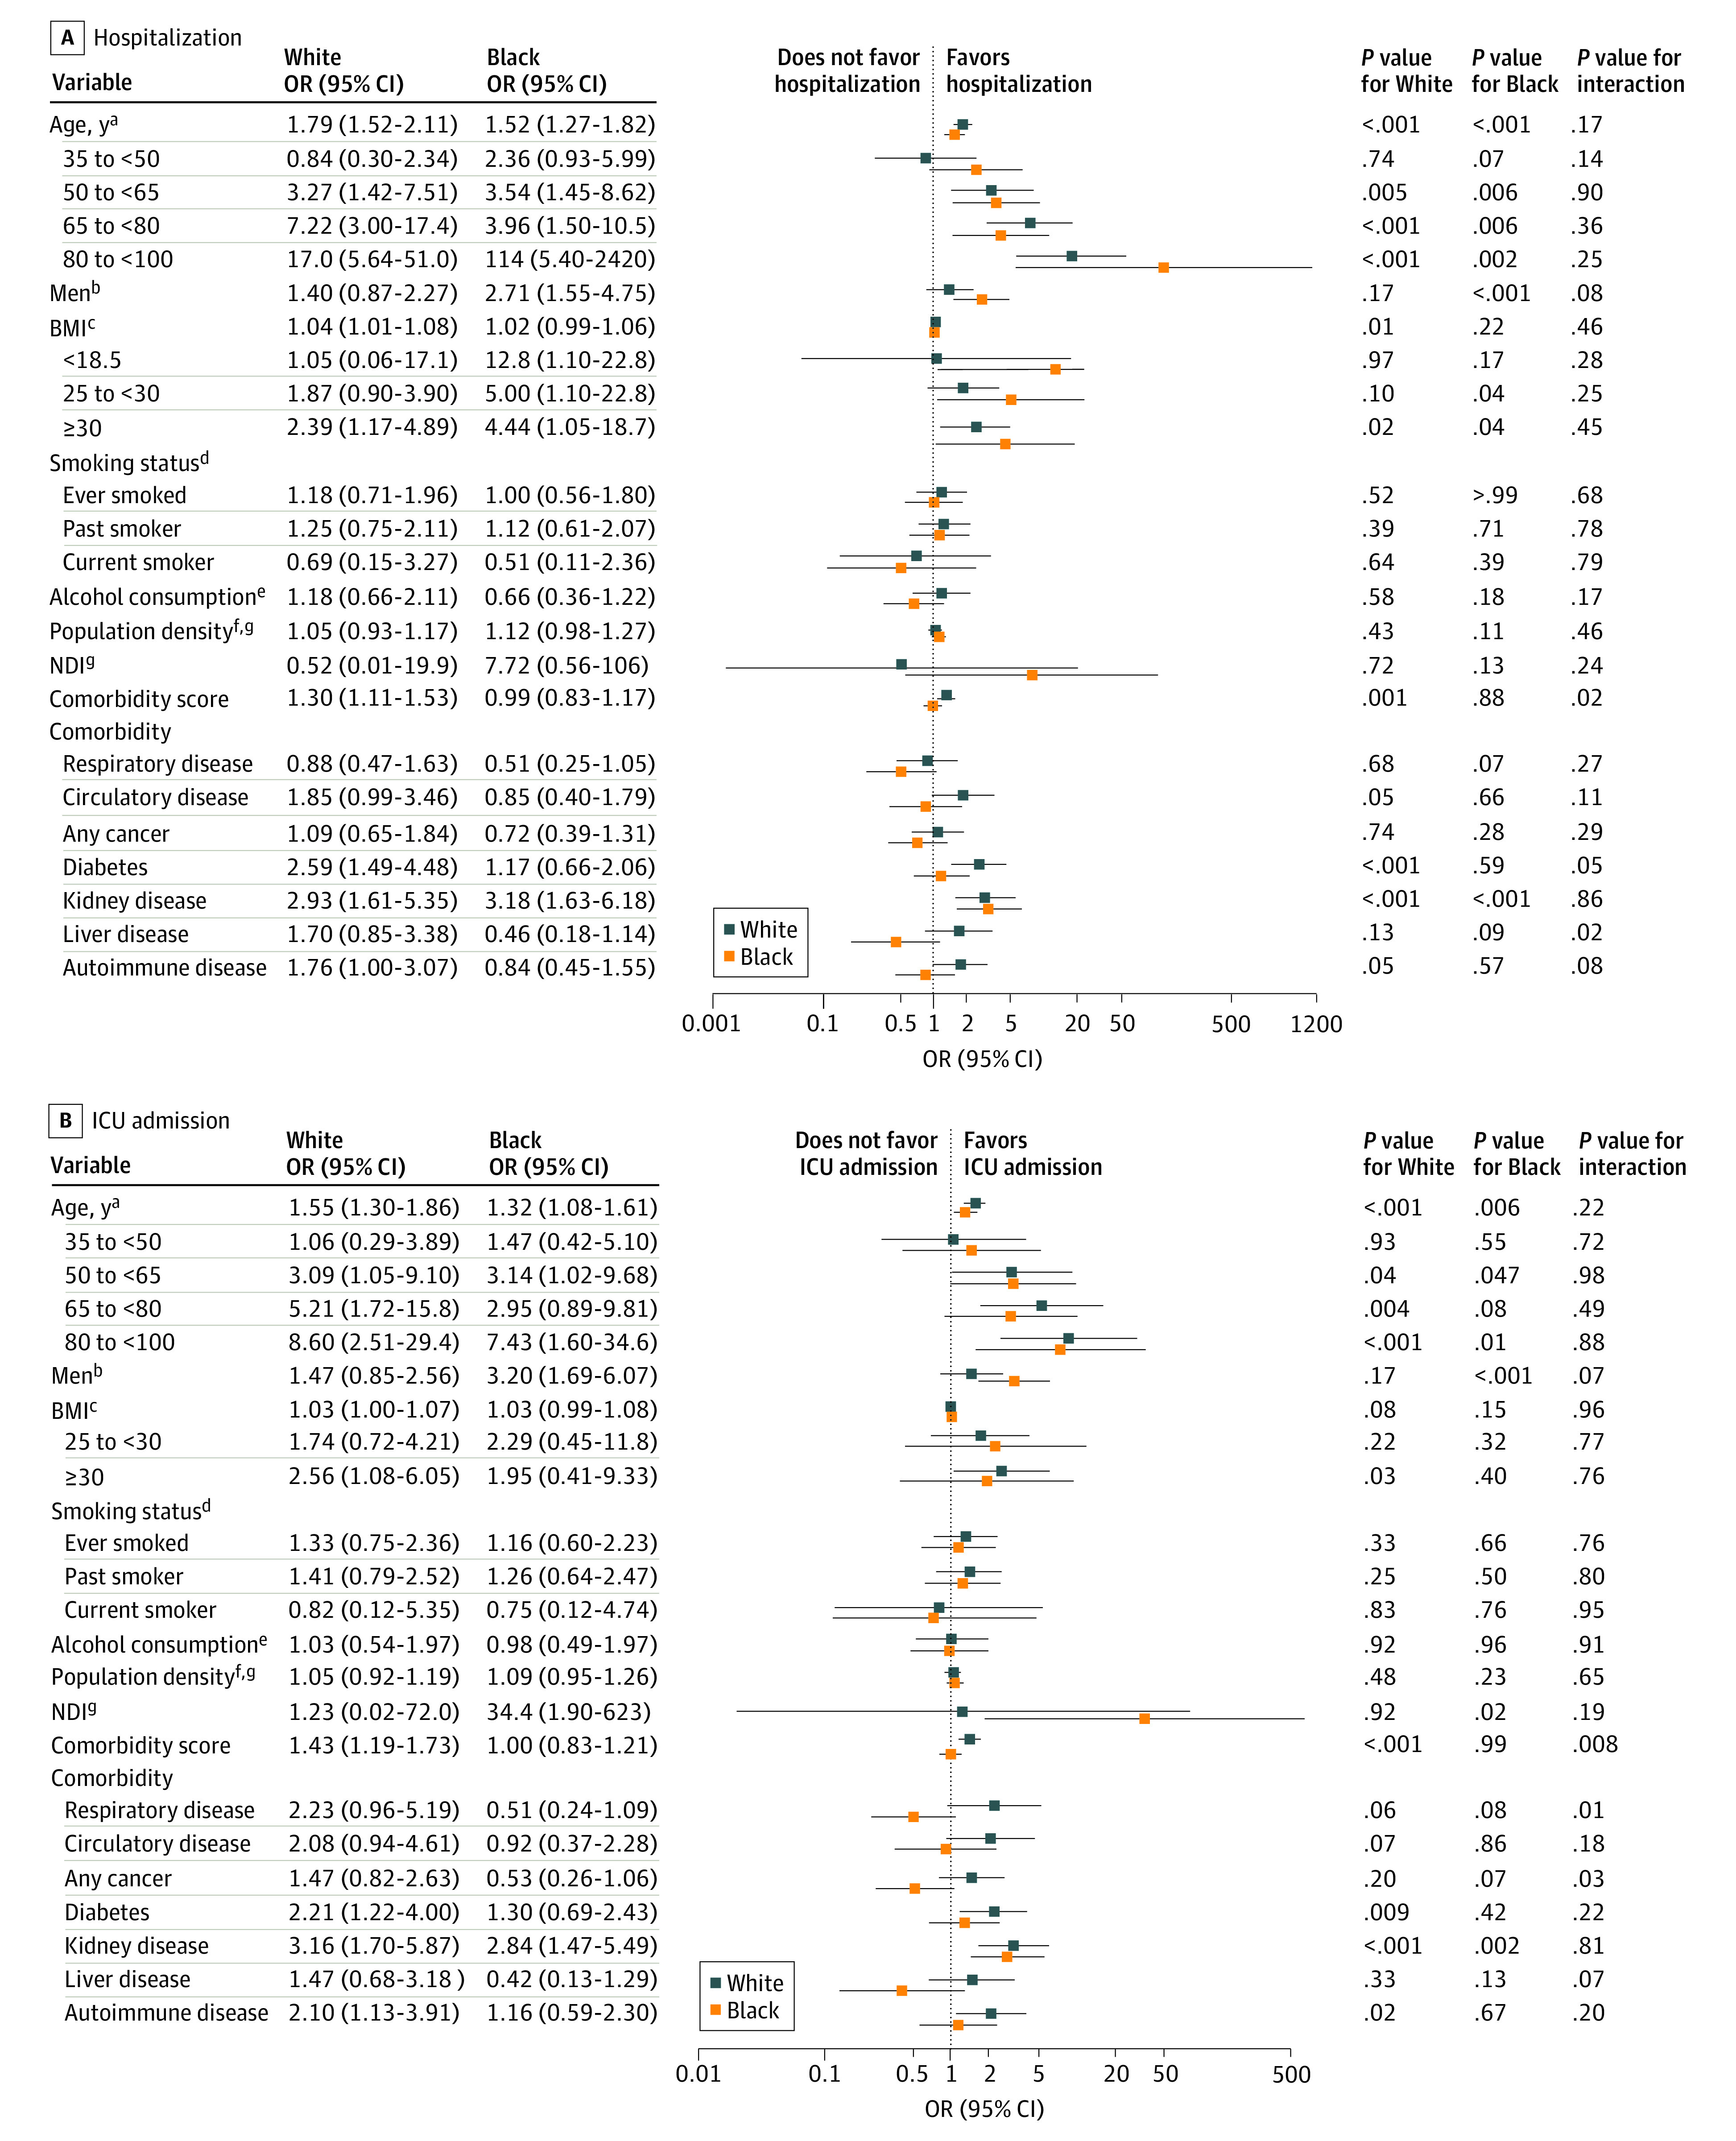
Coronavirus Disease 2019 Outcomes for White and Black Patients The results were from model logit P(YCOVID = 1|X, Covariate) = β0 + βXX + βRaceRace + βintX × Race + βcovCovariate, in which YCOVID = Yhospitalization (A) or YCOVID = YICU (B) and Covariate = age + sex + NDI (+ comorbidity score in demographic and socioeconomic status models).aReference: age 18 to younger than 35 years.bReference: women.cReference: BMI 18.5 to less than 25.dReference: never smoker.eReference: no alcohol consumption.fPer 1000 persons per square mile.gFrom 2010 census data.